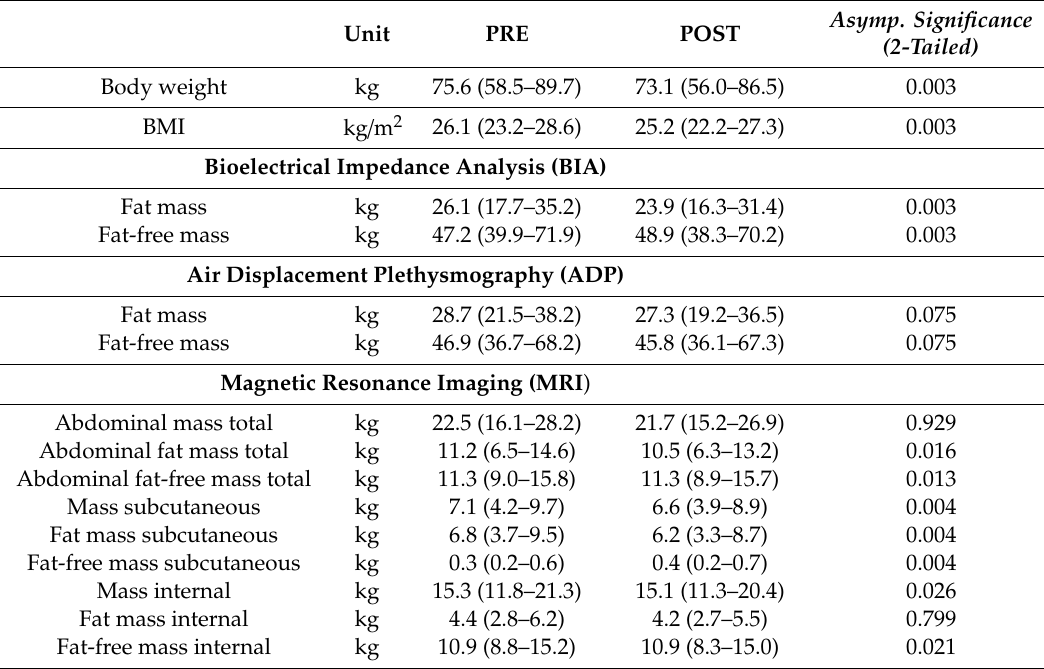
Table 1. PRE and POST mass values estimated by the three modalities BIA, ADP, and MRI. Unit PRE POST